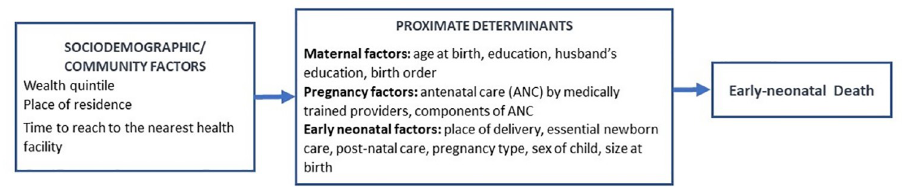
Fig 1. Conceptual framework of early neonatal